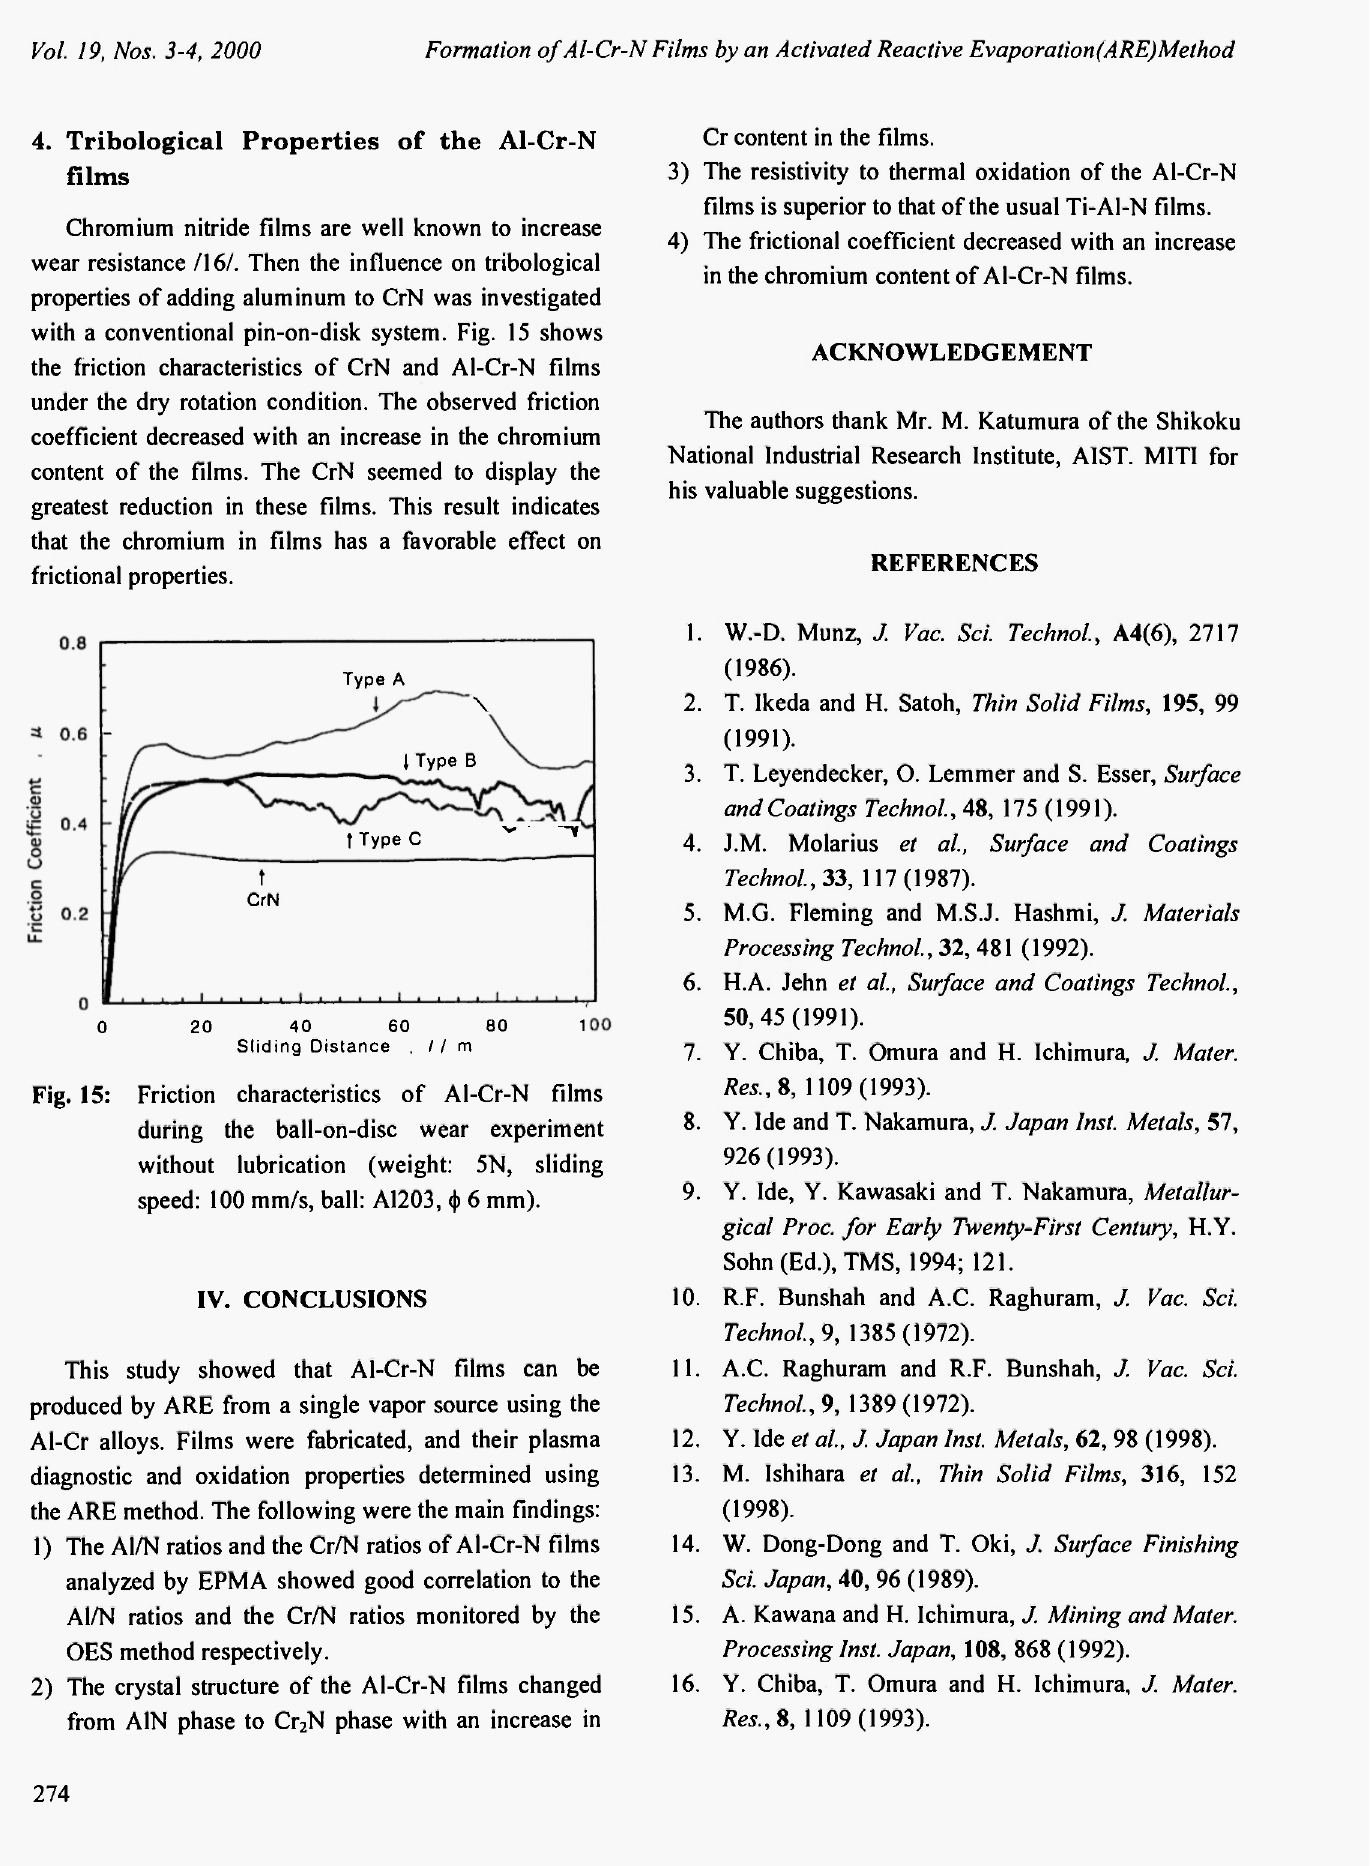
Fig. 15: Friction characteristics of Al-Cr-N films during the ball-on-disc wear experiment without lubrication (weight: 5N, sliding speed: 100 mm/s, ball: A1203, φ 6